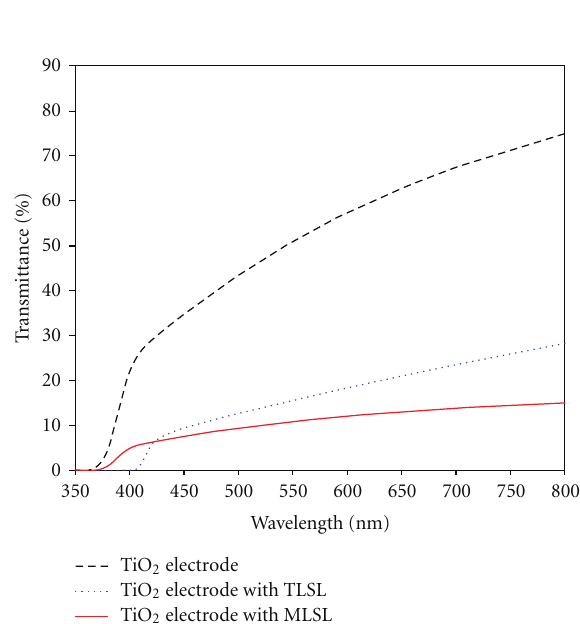
Figure 4: Transmittance spectra of three photo electrodes (undyed TiO 2 electrode: 4 μ m thick; TLSL: 7 μ m thick; MLSL: 7 μ m thick).